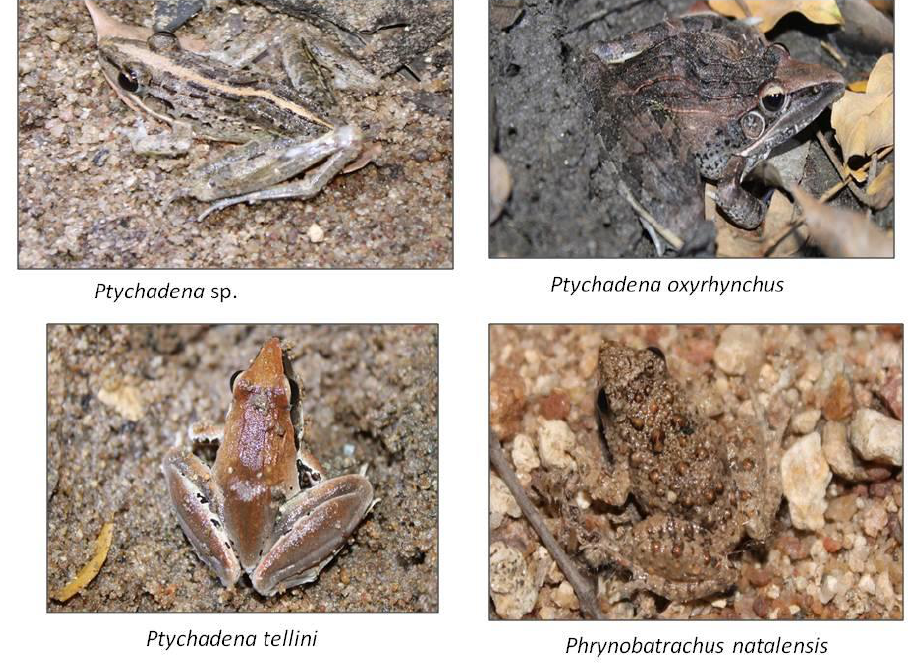
Figure 2. Some of the amphibian species recorded in the present study.